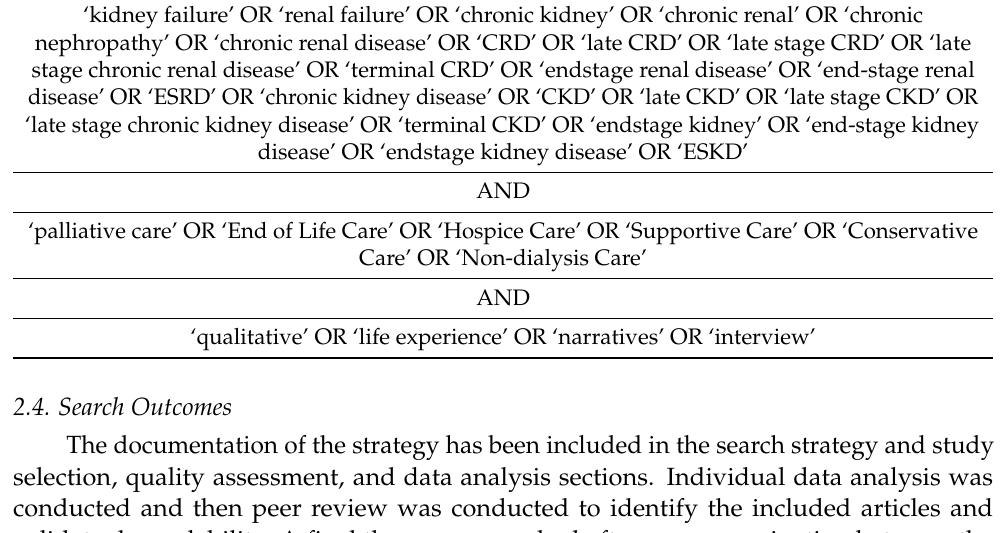
Table 1. Algorithm used in the PubMed Web